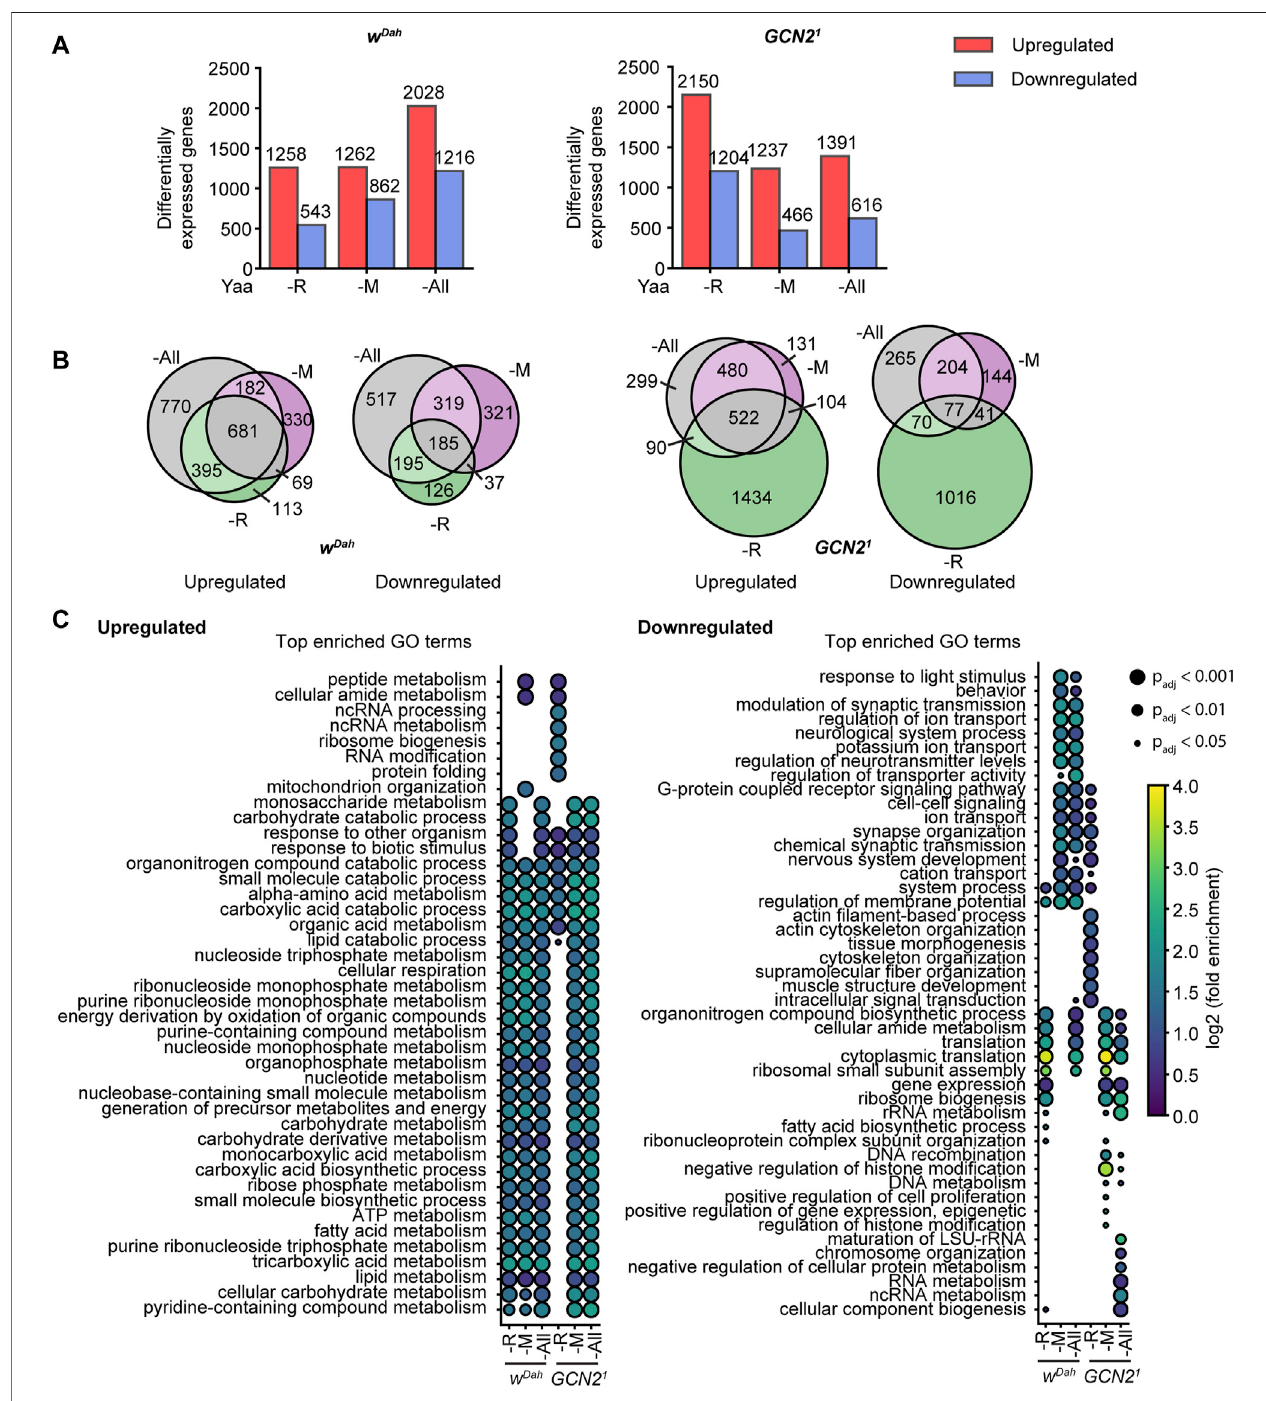
FIGURE 6 | Transcriptional pro fi ling of wild type and GCN2 mutants under amino acid deprivation. (A) Barplot representation of differentially expressed genes (DEGs)in w Dah control(left)and Gcn2 1 mutantfemales(right)under-R,-M,and -Alldeprivation relative totheYaacontroldiet.Theexactnumber ofDEGsforeach dietis indicatedabovethebar. (B) VennrepresentationofgenesetoverlapsofDEGsinthe w Dah controls(left)and GCN2 1 mutants(right)under-R,-M,and-Alldeprivation. (C) Dotplotrepresentationofsigni fi cantlyenrichedtopGOtermssortedbyadjusted p -valueofupanddownregulatedgenesineachgenotypeanddiet. n =3replicates per genotype and